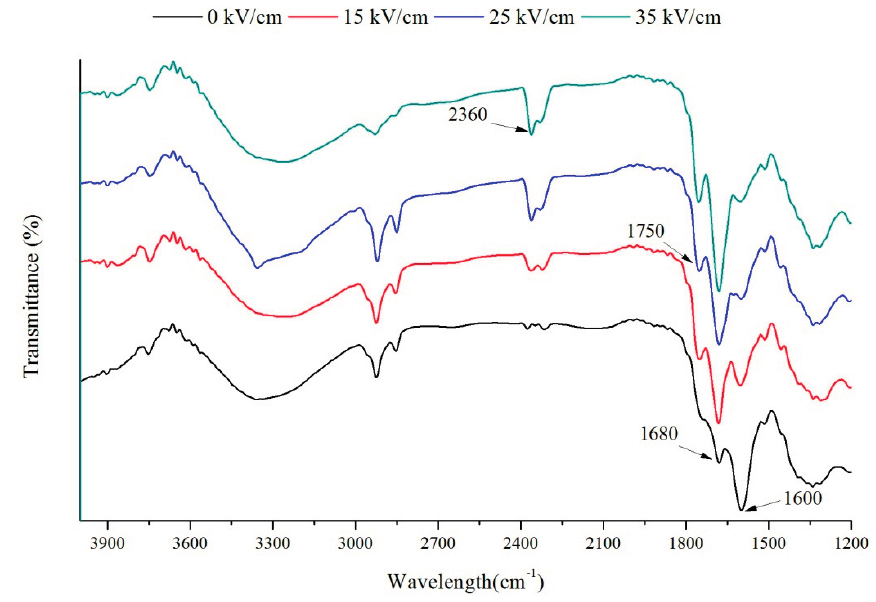
Figure 4. Fourier transform infrared (FTIR) spectra of VIT-C solution by PEF